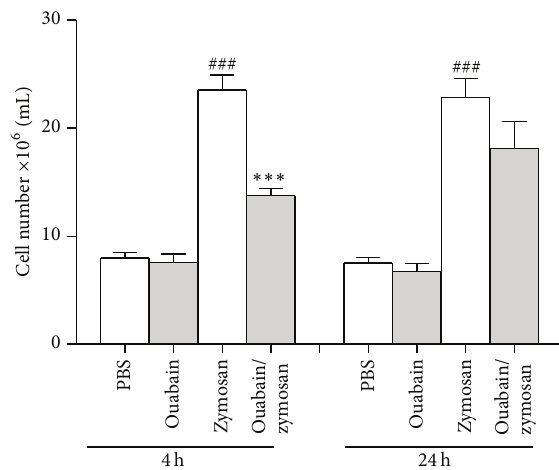
Figure 2: Total cell number in the peritoneal cavity 4 and 24 h after injection with zymosan. Swiss mice ( 𝑛 = 8 ) were treated with 0.56 mg/kg of ouabain (i.p.) or PBS for 3 consecutive days. One hour after the last dose of treatment, animals were stimulated with zymosan (i.p.). Four and 24 hours after challenge with zymosan, peritoneal exudate was collected and total leukocyte counts were performed. Results were expressed as mean ± SEM and analyzed by Graphpad Prism using ANOVA with Tukey’s posttest, where all groups were compared. ### 𝑃 < 0.001 versus PBS group and ∗∗∗ 𝑃 < 0.01 versus zymosan